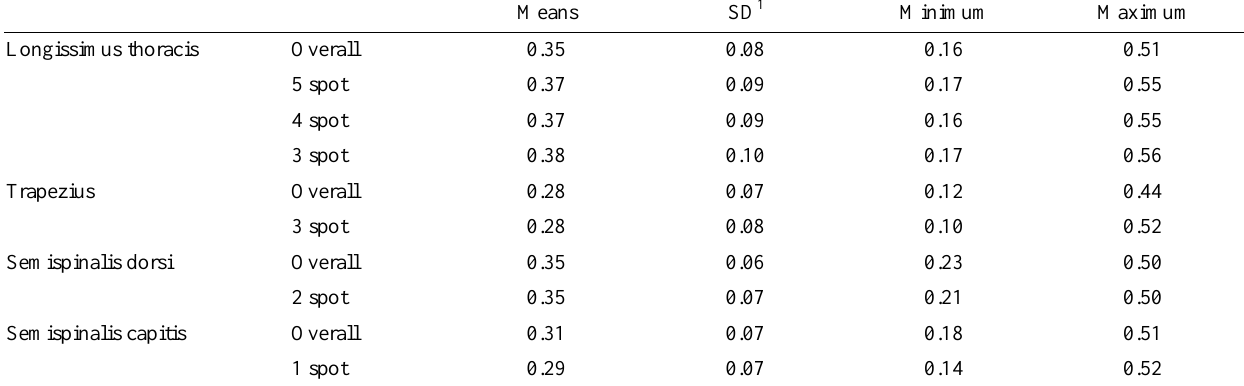
Table 1. Measurements of beef marbling (fat area ratio) between longissimus thoracis, trapezius, semispinalis dorsi and semispinalis capitis muscles by image analysis